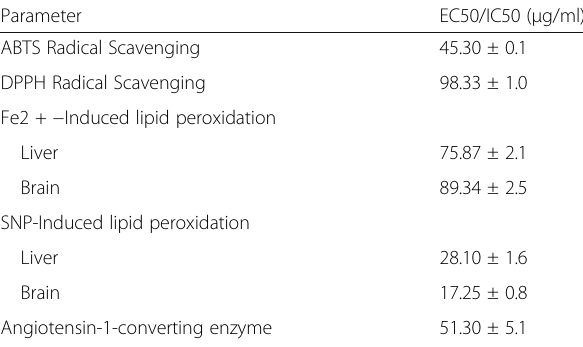
Table 1 EC 50 values of aqueous-methanolic extract of P. biglobosa leaf for ABTS, DPPH radicals scavenging, toxicant-induced lipid peroxidation and IC 50 for Angiotensin-1-converting enzyme